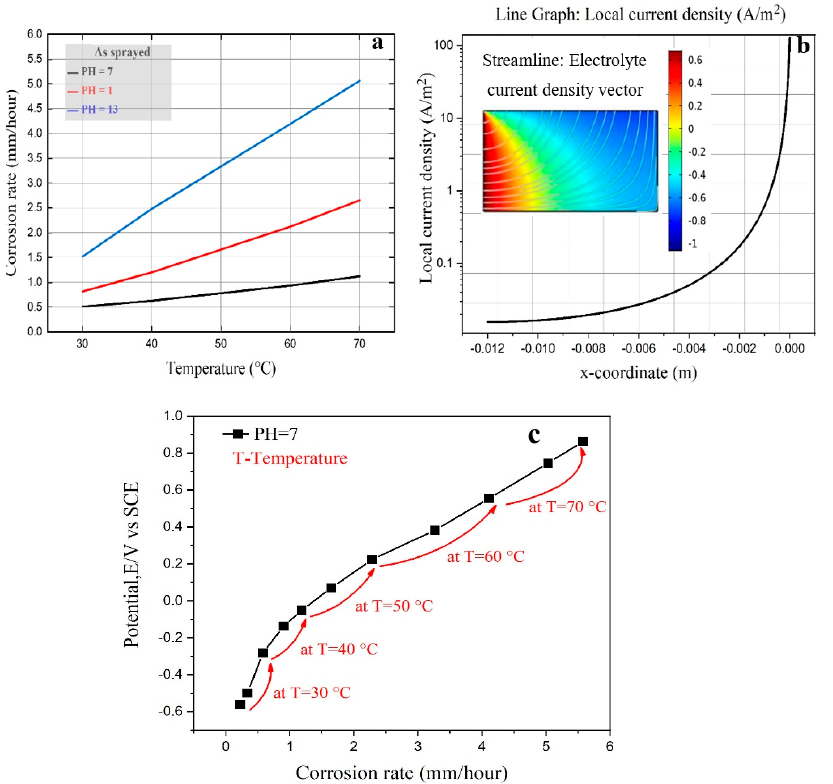
Figure 11. ( a ) Corrosion rate with various temperatures, ( b ) local current density vs. disc radii for 3.5% NaCl electrolyte and ( c ) the relationship between corrosion potential and corrosion rate.